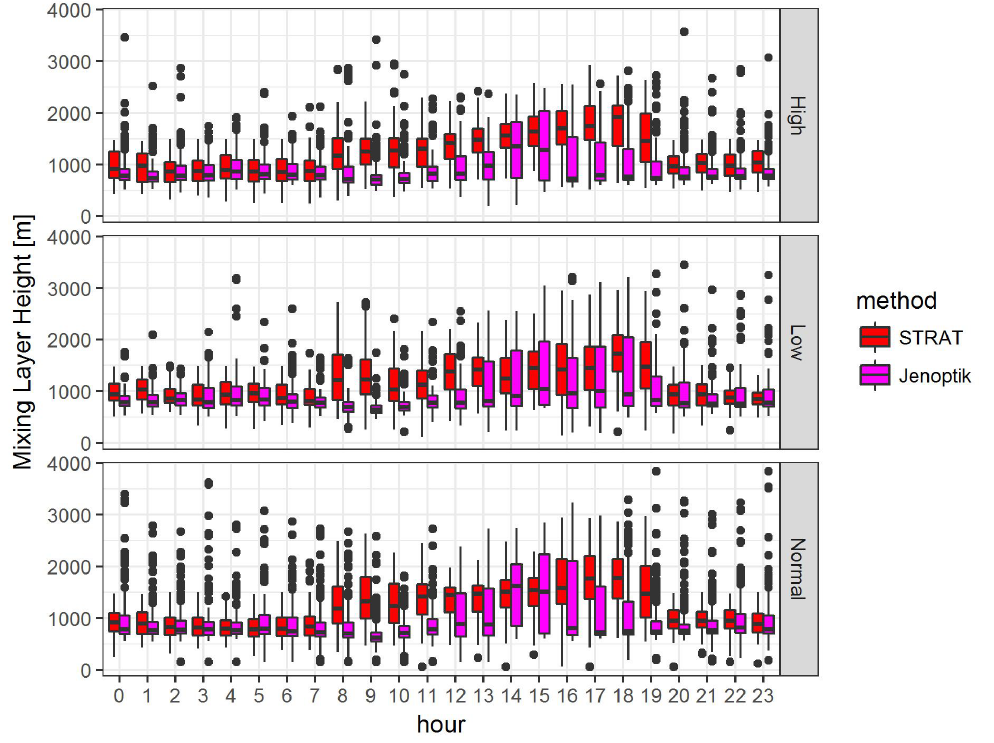
Figure 8. Diurnal cycle of the MLH over Sofia determined by STRAT (red) and Jenoptik (magenta) algorithms as a box and whiskers plot (in Tukey’s style) at “High”, “Low” and “Normal” atmospheric pressure in summer of